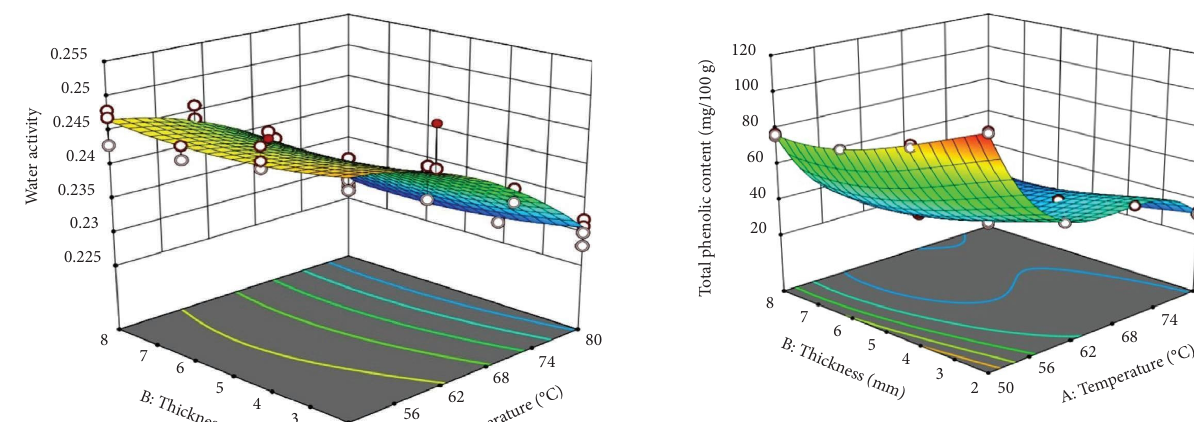
Figure 3: Infuence of tray-drying conditions on the total phenolic content of green banana four. ) w